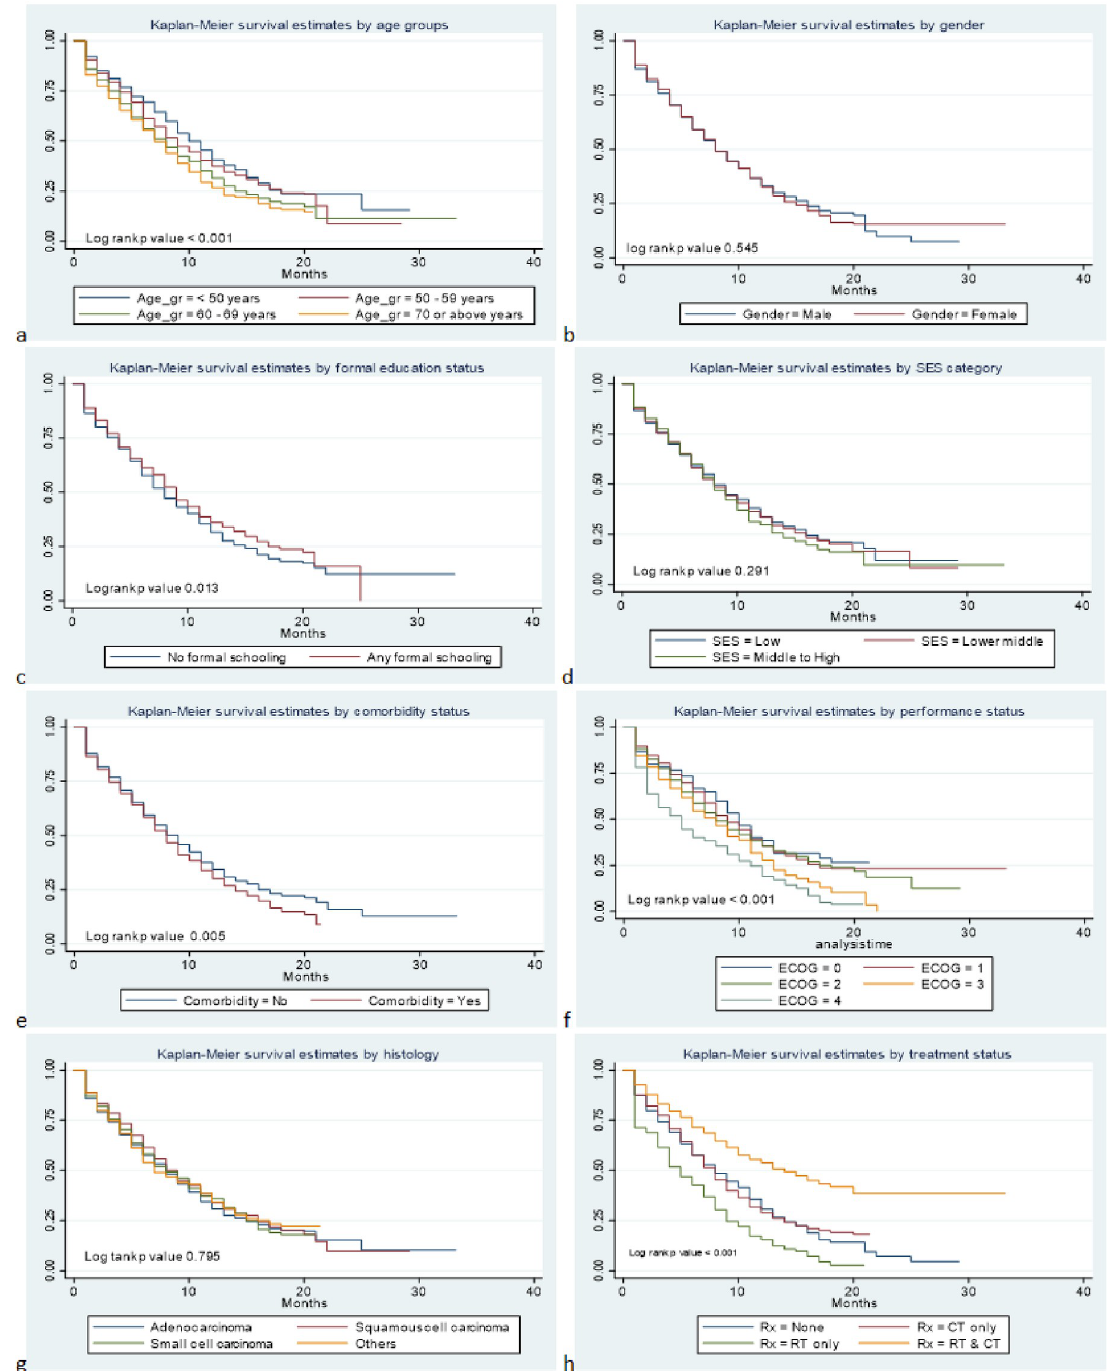
Fig 1. Kaplan-Meier curves illustrating comparison of survival estimates across strata of age (a), gender (b), smoking status (c), SES (d), Comorbidity status (e), ECOG performance status (f), Histology type (g) and treatment type (h). Statistical significance of difference was determined by log rank test p value <